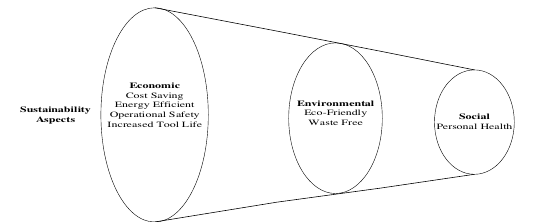
Fig. 1: Sustainable Dry Machining Model